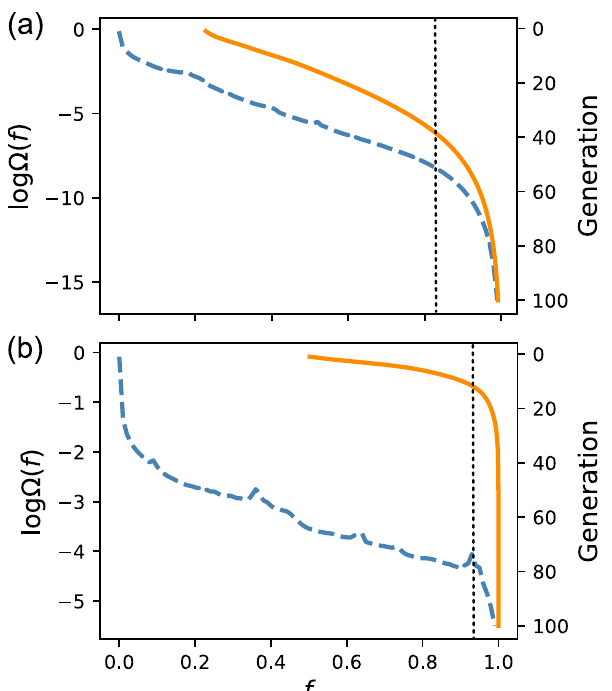
Fig 1. Genotypic entropy and evolution of fitness. The fitness f is divided into 100 bins. The blue dashed lines (left axis) show the base 10 logarithms of the appearance probability O ( f ) of each bin, obtained by random sampling. The orange solid lines (right axis) represent the average fitness of each generation calculated for the lineages obtained using Evo50. Averages were taken over 100,000 lineages. The vertical lines indicate the fitness at which O ( f ) starts to decrease faster than the exponential rate. (a) β = 2 and μ = 0. (b) β = 4 and μ = 0.